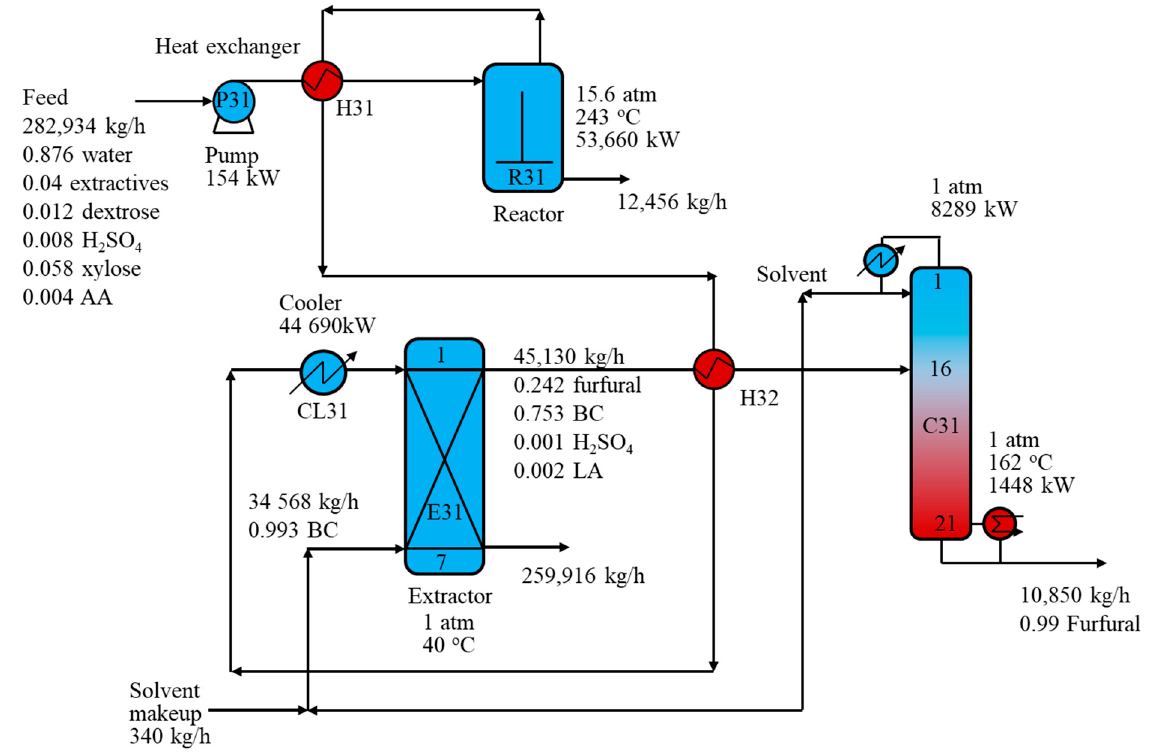
Figure 5. Schematic of the furfural reaction-extraction/distillation process with butyl chloride solvent.